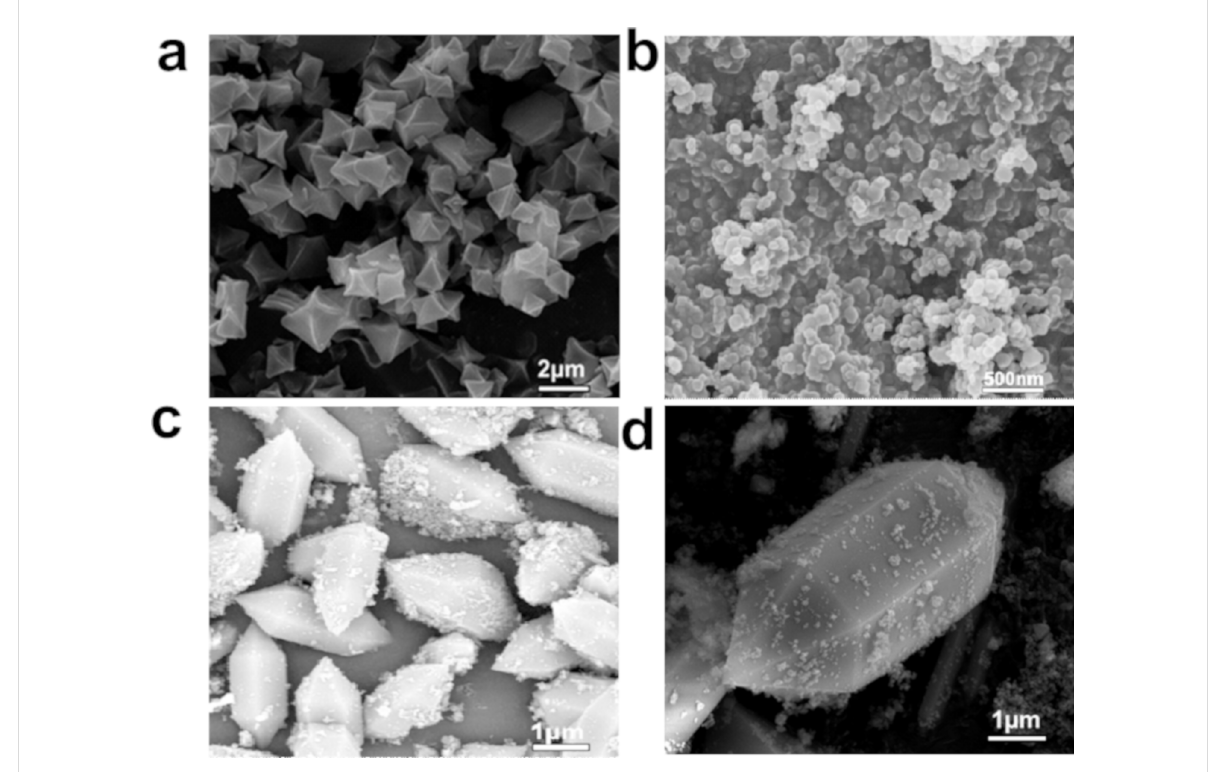
Figure 2: SEM images of (a) MIL101(Fe), (b) Bi 2 O 3 , and (c,d) BOM-20.